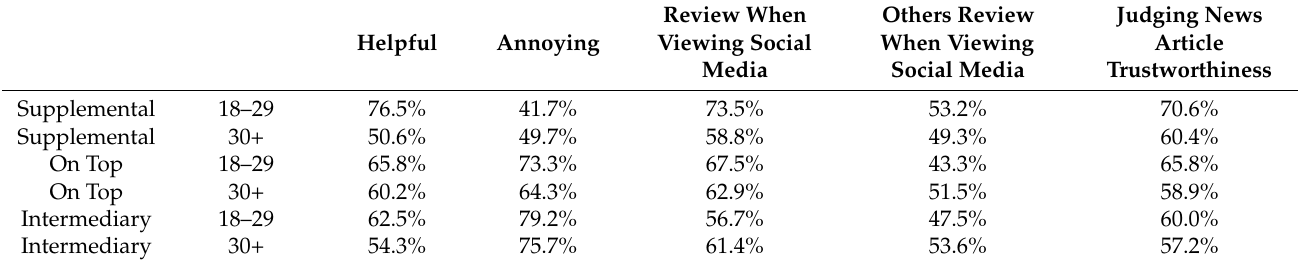
Table 17. Informational/warning survey results by category and by age group.